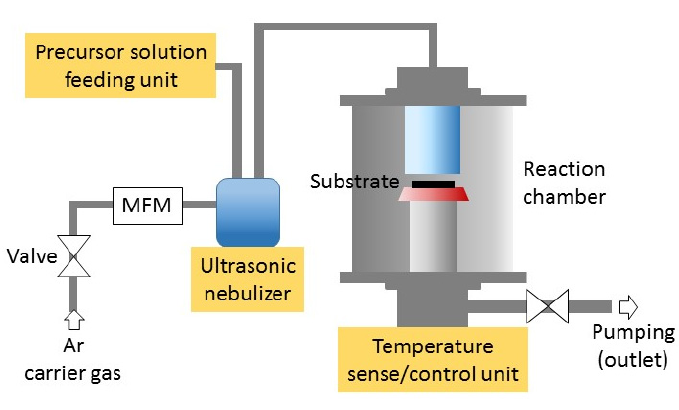
Figure 1. Schematics of an AACVD system. MFM: Mass flow meter.